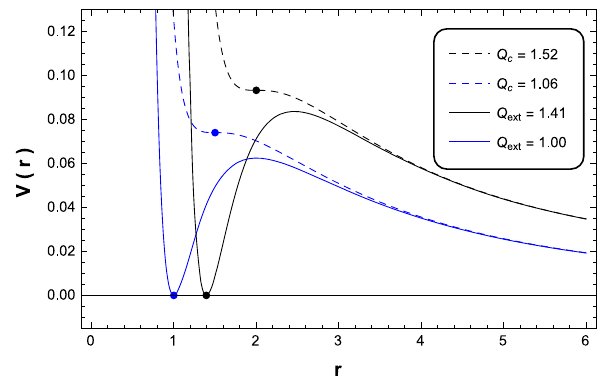
Fig. 4 Plot of the effective potential of photons as a function of r for different values of the charge Q . Here we have used the values L = 1, and M = 1. Blue line corresponds to four-dimensional RN spacetime Q ext = 1 . 0 r + = 1, Q c = 1 . 06, and the radius of the last unstable circular orbit is r u = 1 . 5. Black line corresponds to five-dimensional RN AdS spacetime with (cid:4) = 10, Q ext = 1 . 41, r + = 1 . 39, Q c = 1 . 52, and the radius of the last unstable circular orbit is r u =